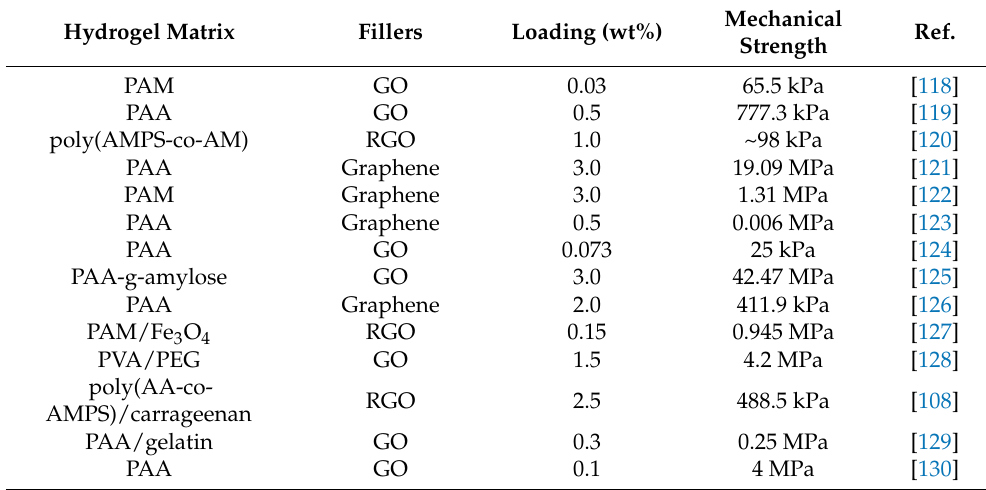
Table 2. Graphene-based hydrogels, their preparation methods, and reinforcement loading concen-